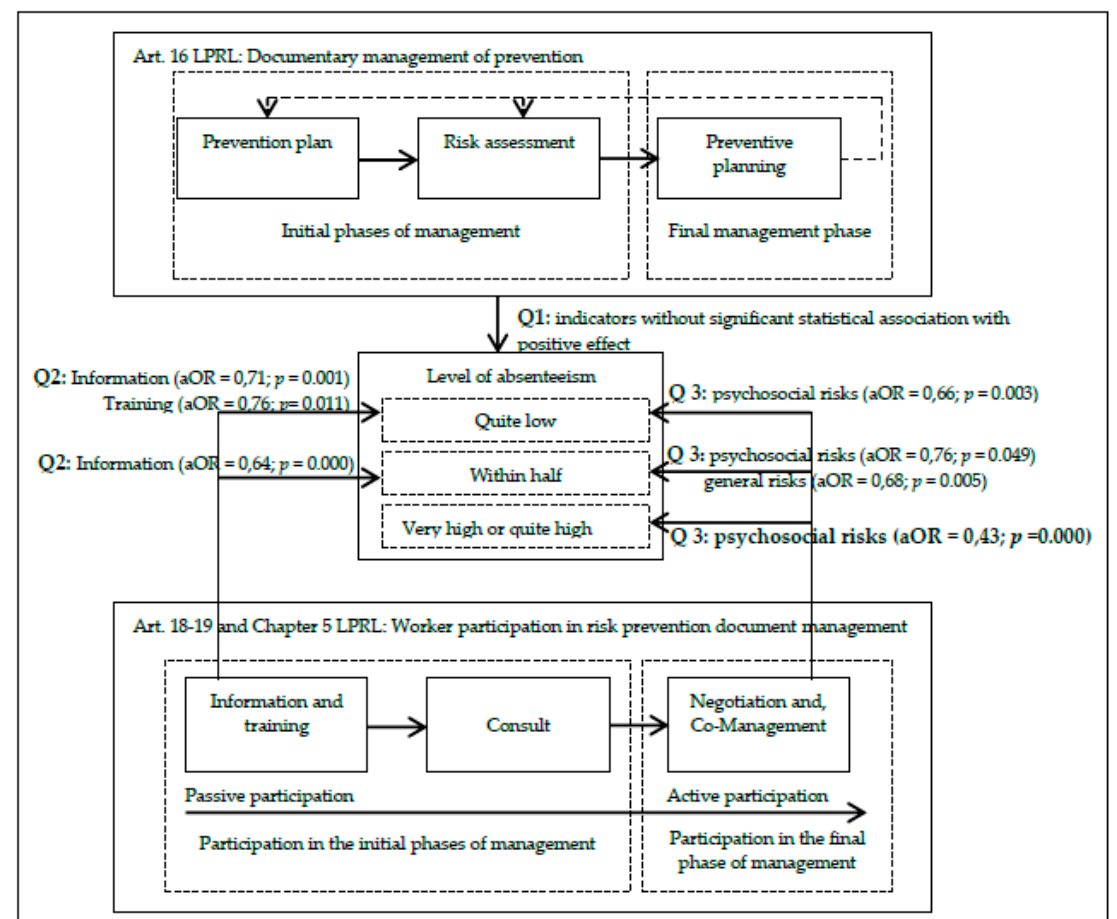
Figure 2. Results of the Participatory Management System for the Prevention of Occupational Risks.